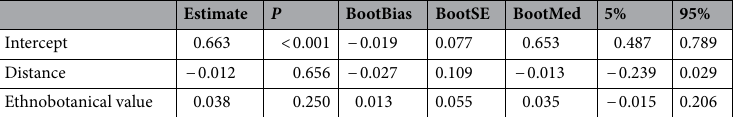
Table 5. Bootstrap regression testing the effects of the distance between agroforestry systems and their surrounding vegetation and ethnobotanical value on Shannon diversity